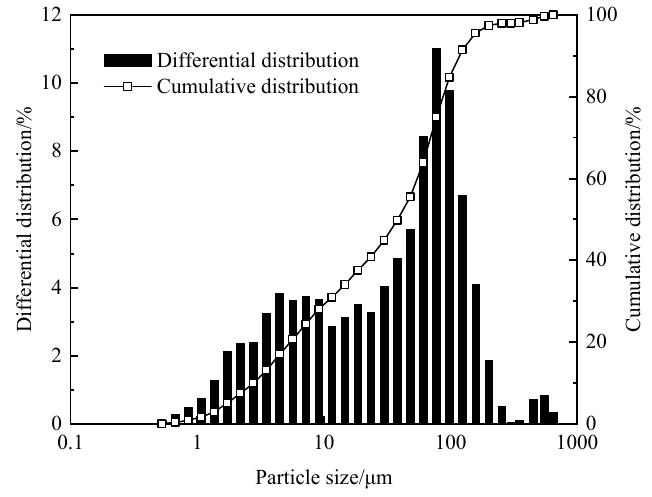
Figure 2. The whole tailing particle size distribution. Table 1. The characteristic value of full tailing particle size.